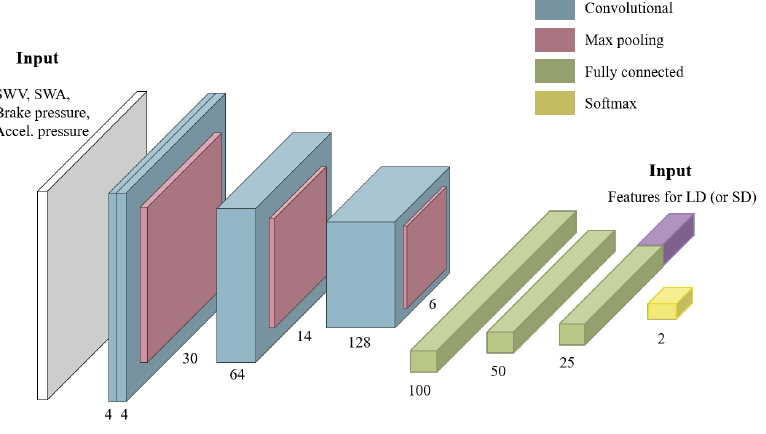
Figure 6. Proposed subnetwork